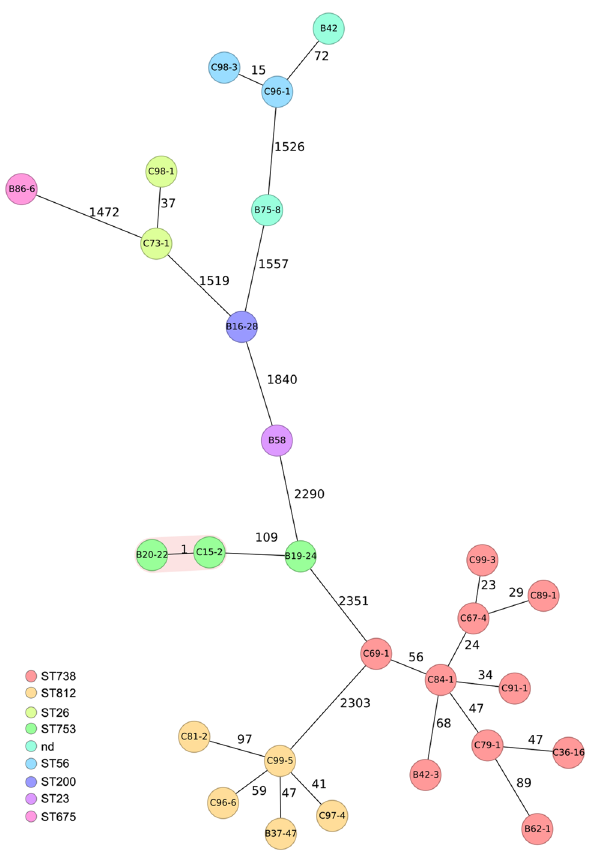
Figure 1. Phylogenetic relationship of 27 Shiga toxin-producing Escherichia coli (STEC) isolated from game meat based on their core genome multilocus sequence type (cgMLST) allelic profiles. The minimum spanning tree was generated using SeqSphere (Ridom GmbH). Numbers on connecting lines indicate the number of allele differences between two strains. The colors of the circles represent STs according to the Warwick scheme (http:// enter obase. warwi ck. ac. uk). Strain IDs are indicated in the